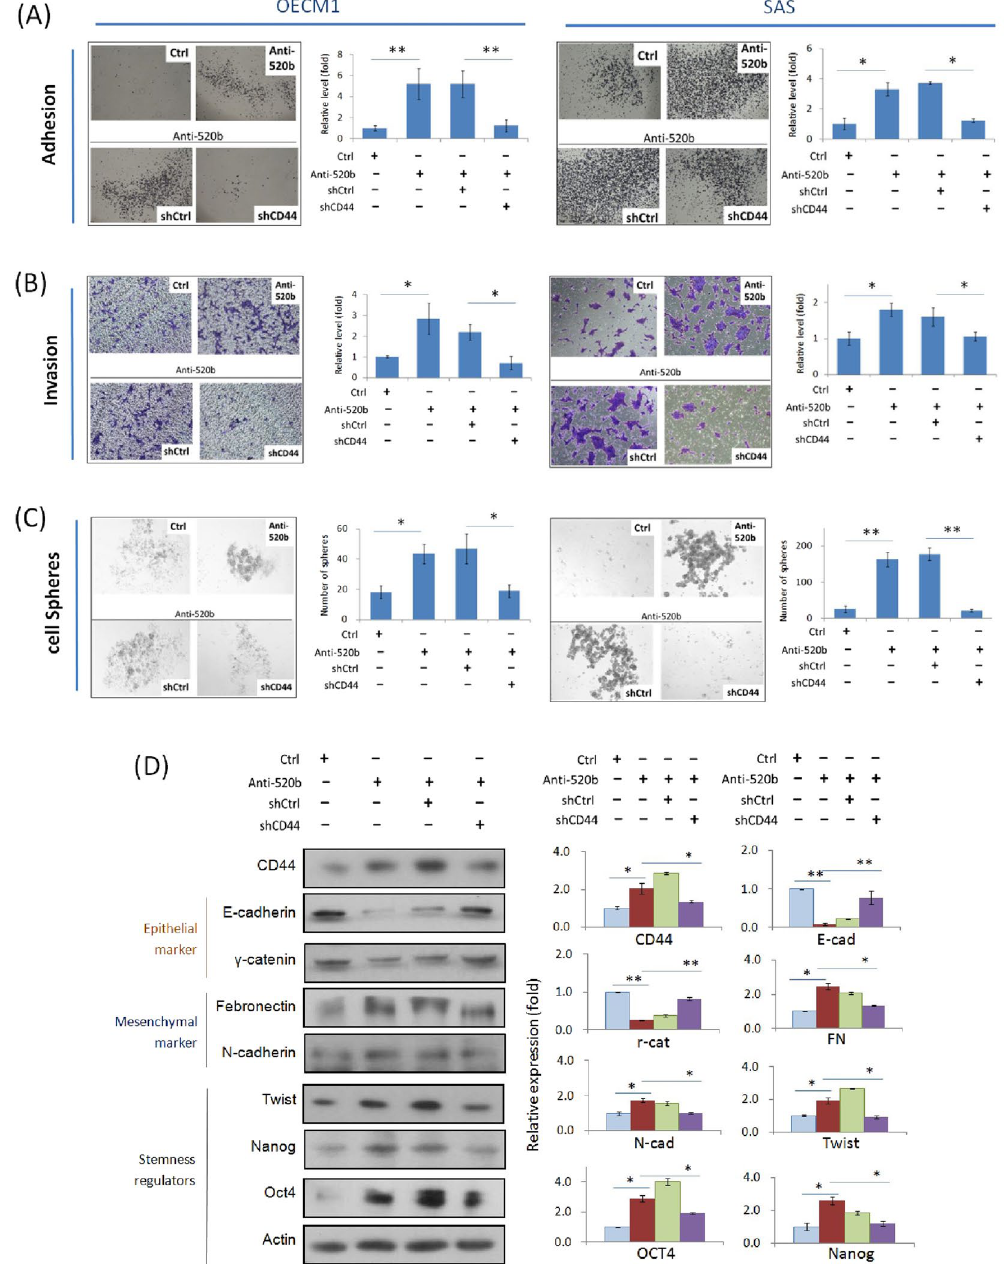
Figure 6. Cellular function of miR-520b occurs through modulation of CD44. Cell adhesion ( A ), invasion ( B ) and sphere formation ( C ) were examined in OECM1 ad SAS cells as described in the Methods section. ( D ) EMT and cancer stemness associated protein expressions were determined by western blot analysis. Actin protein levels were used as an internal control. The relative density of each sample was determined after normalization to the actin level. All the experiments were performed three times independently and that typical results were shown. The error bars shown in the relevant figures indicated the standard deviation of the quantification results in all experiments. ( * p < 0.05, ** p < 0.01,